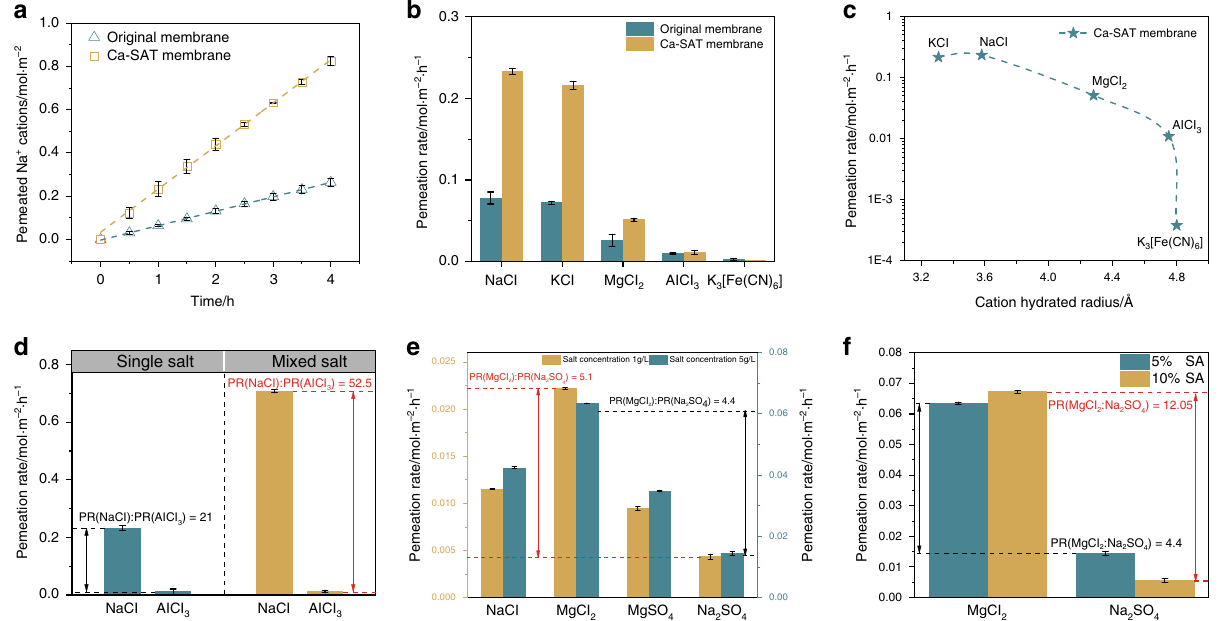
Fig. 4 Ion permeation characteristics through original and pillared membrane membranes. a Number of Na + ions permeated through the original and Ca-SAT membranes. b Permeation rate (PR) of the original and Ca-SAT membranes for different salts. c Relationship between PR and ion radius for the Ca-SAT membrane. d PR of 0.5 mol L − 1 NaCl and AlCl 3 single salt solution compared with that of mixed salt solution. e PR of the Mn-SAT membrane for different ion pairs (NaCl, MgCl 2 , MgSO 4 , and Na 2 SO 4 ). f PR of the Mn-SAT membrane containing different amounts of SA for MgCl 2 and Na 2 SO 4 . The error bars represent the standard deviations of three parallel